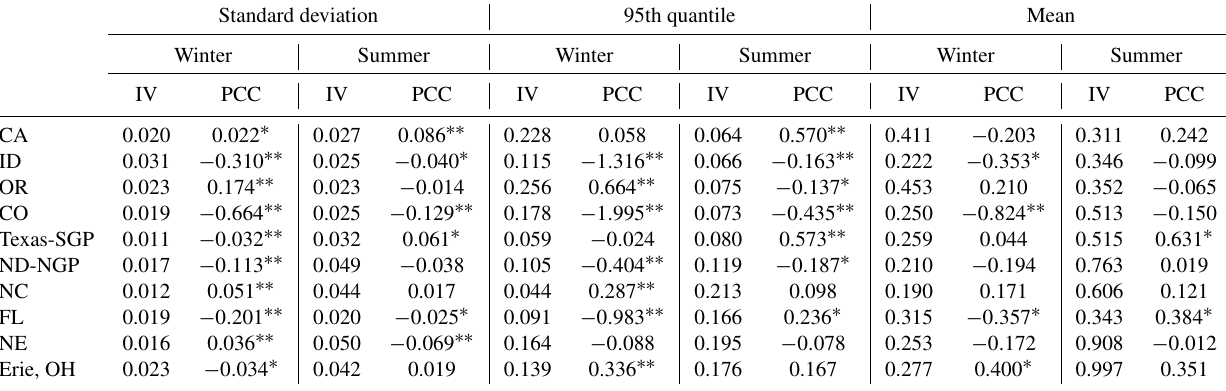
> 1, and the double asterisk indicates PCC > 2. IV IV